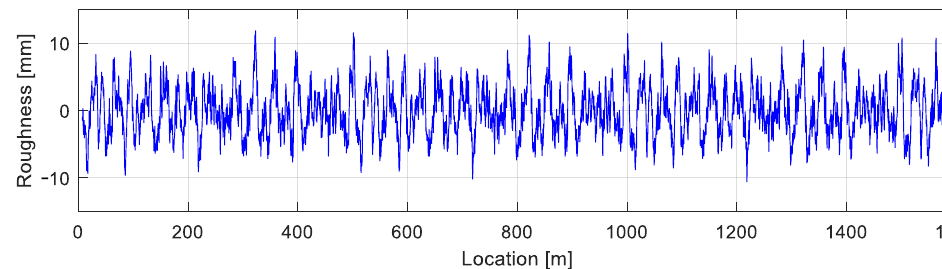
Figure 17. Time histories of the simulated road roughness.